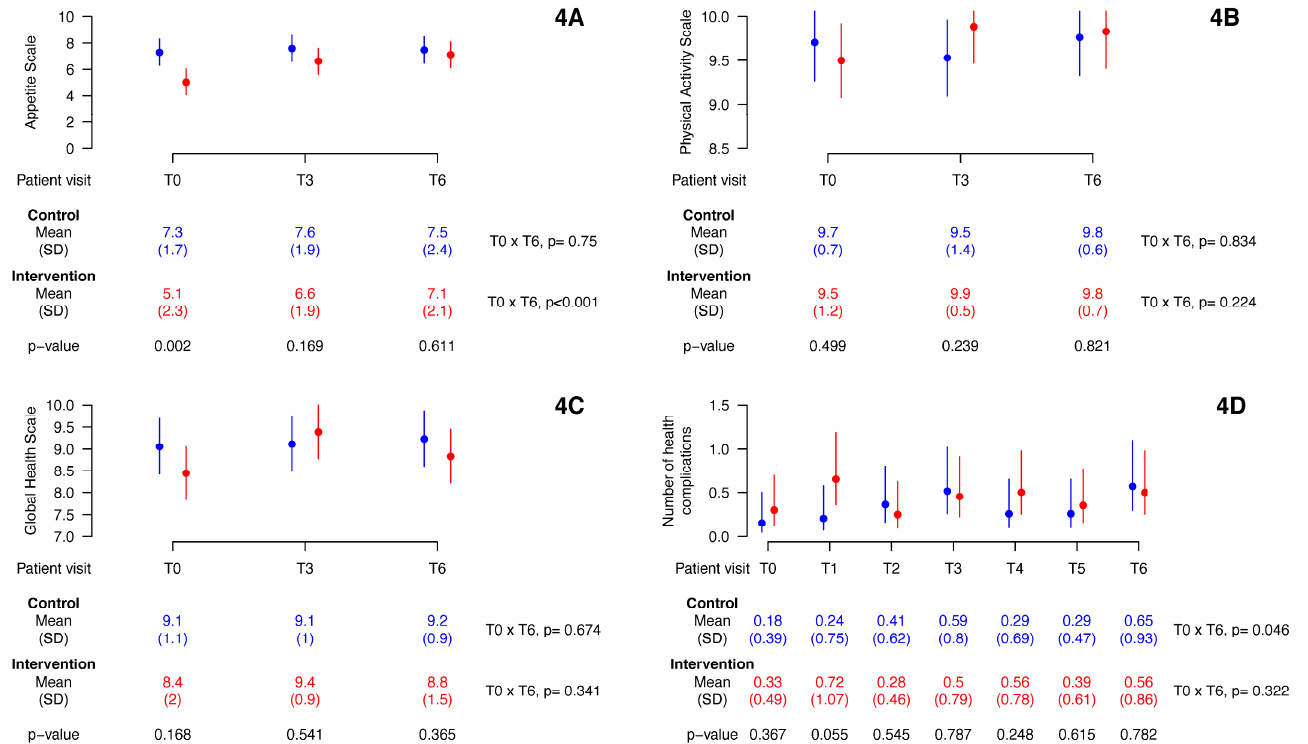
Figure 4. Health complications and scores on appetite, physical activity, and global health scales. Vertical lines are 95% confidence intervals. p : longitudinal mixed effects linear model. ( 4A ) appetite scale vs. time; ( 4B ) physical activity scale vs. time; ( 4C ) global health scale vs. time; ( 4D ) number of health complications vs. time